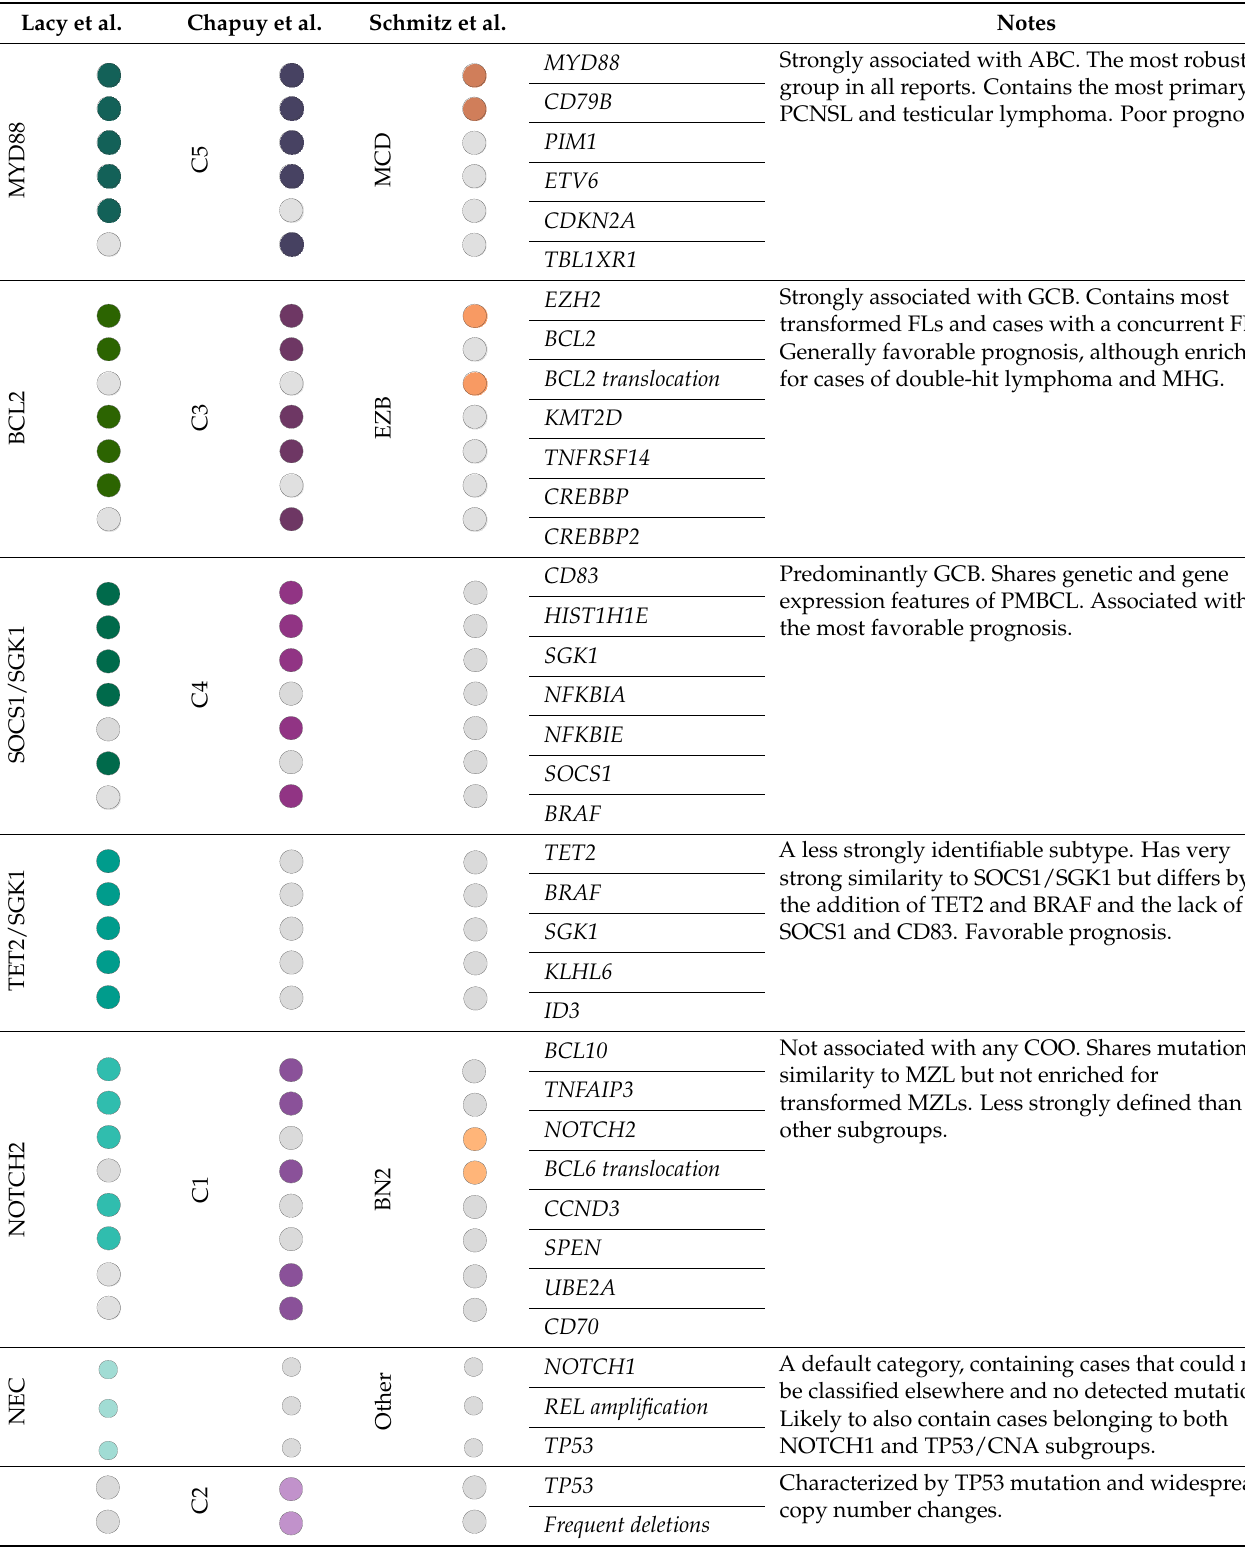
Table 2. Molecular subtypes of DLBCL according to Lacy et al. in comparison with those of Chapuy et al. and Schmitz et al.